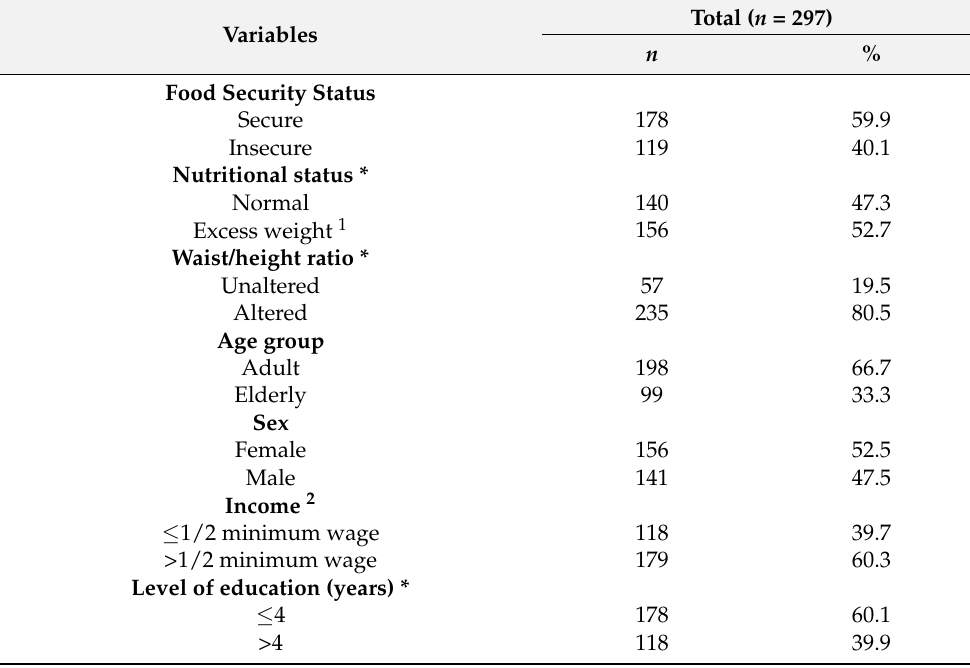
Table 1. Food security, nutritional status, socioeconomic, demographic, and housing conditions of adults and the elderly in a rural municipality of